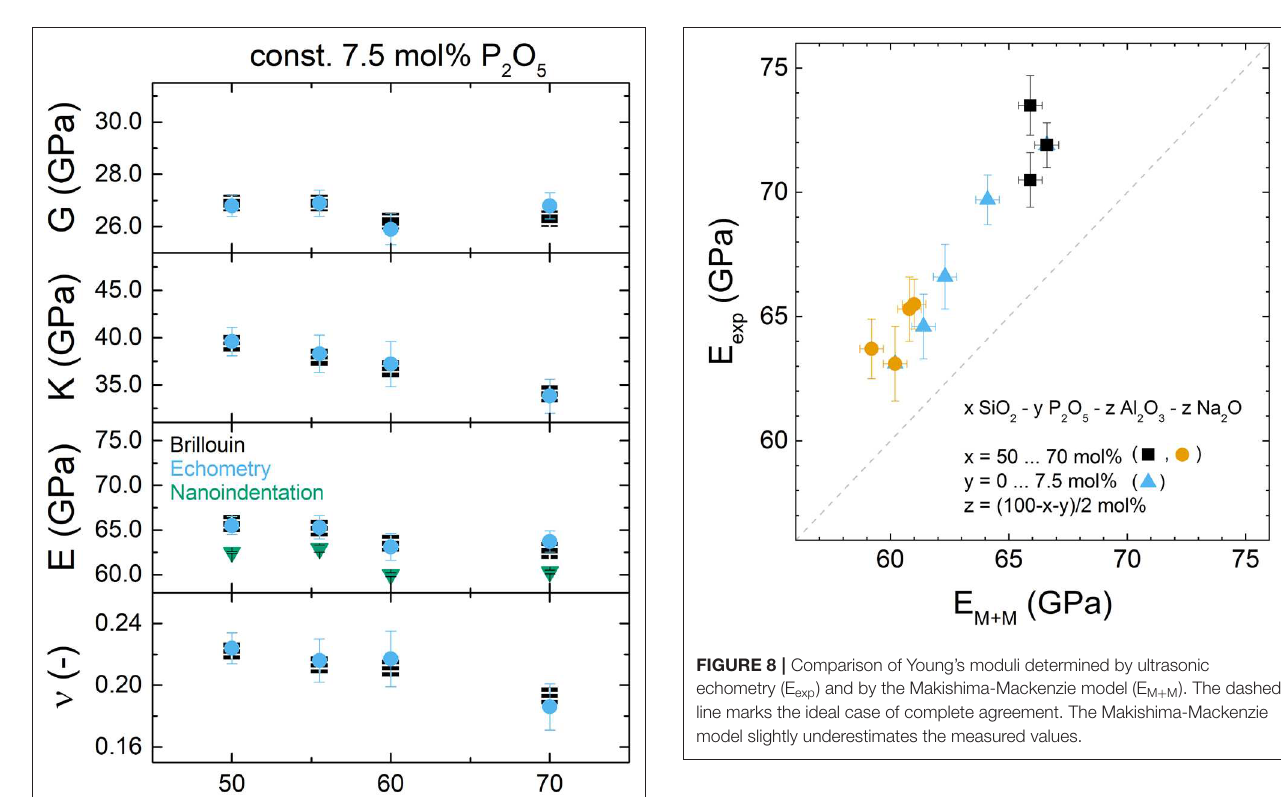
likely to leave metaluminous melts (London et al.,